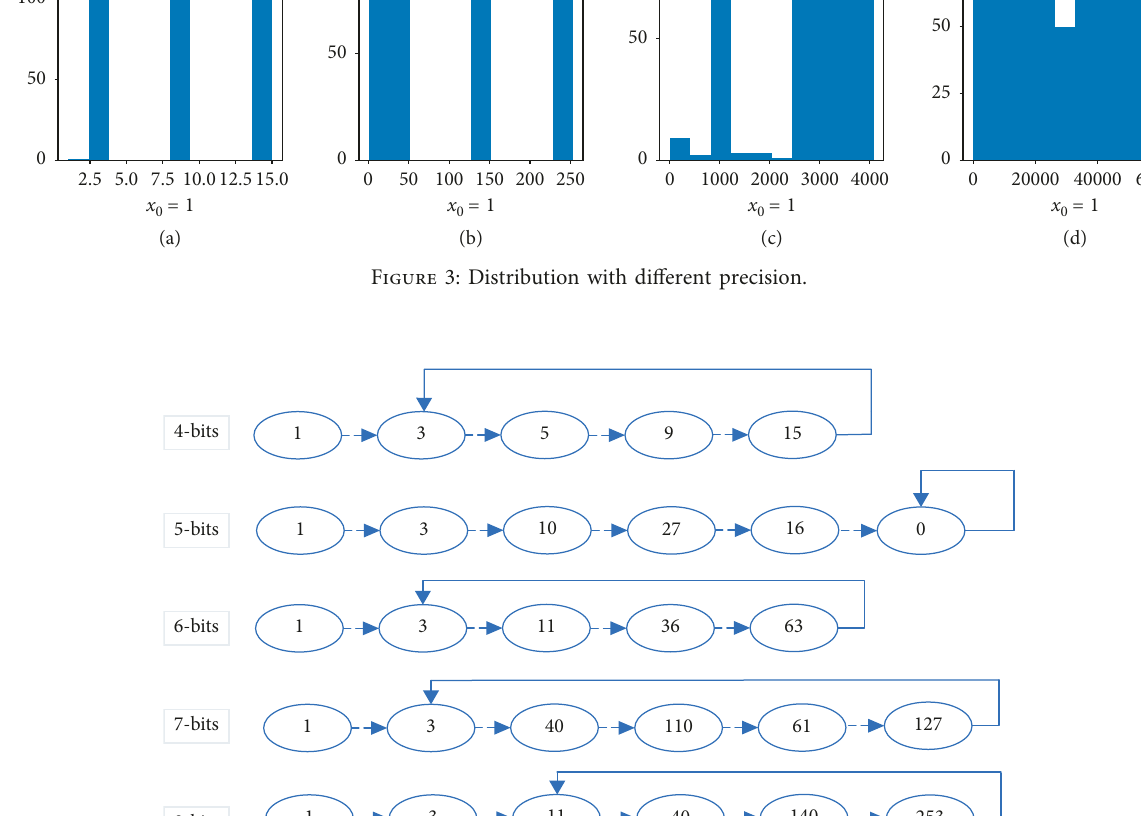
� 1 for different 0